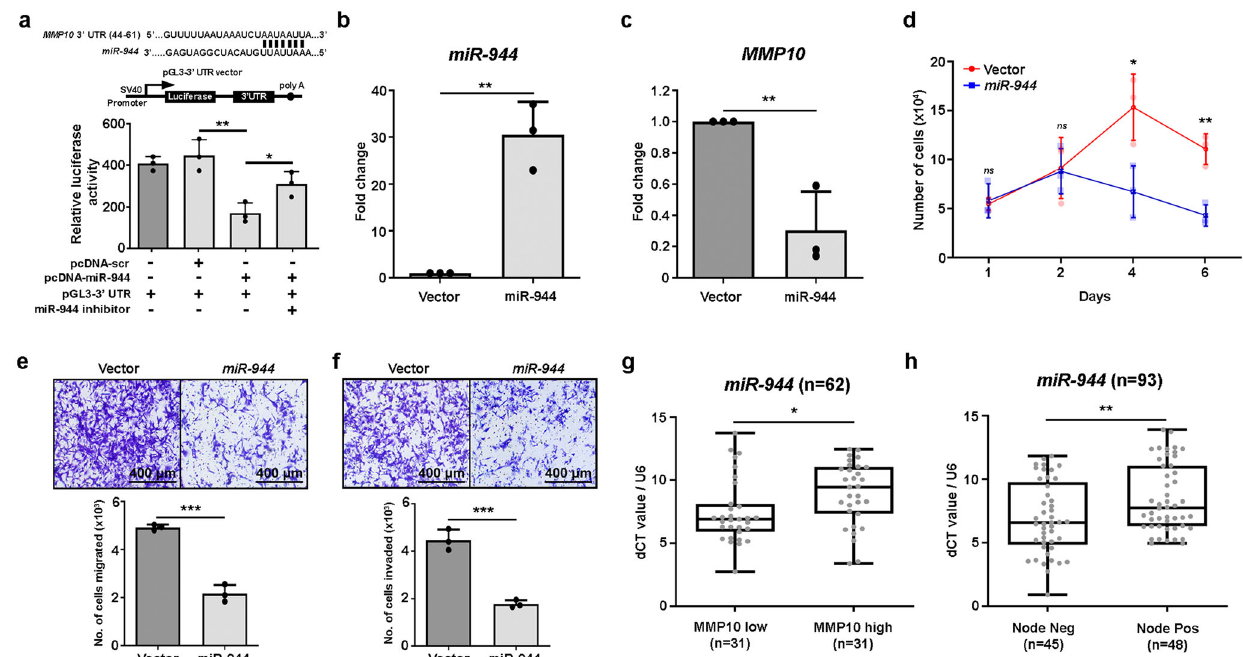
Fig. 3 miR-944 targets MMP10 to suppress metastasis in vitro and in tongue cancer patients. a Schematic diagram shows the miR-94 4 target site on the 3'-UTR region of MMP10 as predicted by TargetScan. Bar plot represents the relative luciferase activity measured by normalizing with the Renilla luciferase. b , c qRT-PCR of miR-944 ( b ) and MMP10 ( c ) expression in AW8507 cells overexpressing empty vector or miR-944 . d Cell proliferation assay of AW8507 cells overexpressing empty vector or miR-944 . Scatter plot indicate the number of live cells on the mentioned day. e , f Cell migration ( e ) and invasion assay ( f ) of AW8507 cells overexpressing empty vector or miR-944 (scale bar = 400 µ m). g qRT-PCR of miR-944 mRNA in 62 primary tongue tumor samples correlated with MMP10 mRNA expression. h qRT-PCR miR-944 mRNA in 93 primary tongue tumor samples correlated with nodal metastasis status of patients. Data are plotted as boxplot representation of dCT values. MMP10 and miR-944 expression are normalized with GAPDH and U6 , respectively. The middle line in the boxplot shows median along with the lower (Q1) and upper quartiles (Q3) as boxes. The whiskers represent the minimum and maximum values. Data are shown as means ± SD. p -values are from Student ’ s unpaired t -test and denoted as ns (not signi fi cant); * p < 0.05; ** p < 0.01; *** p < 0.001. Data shown are representative of n = 3 independent